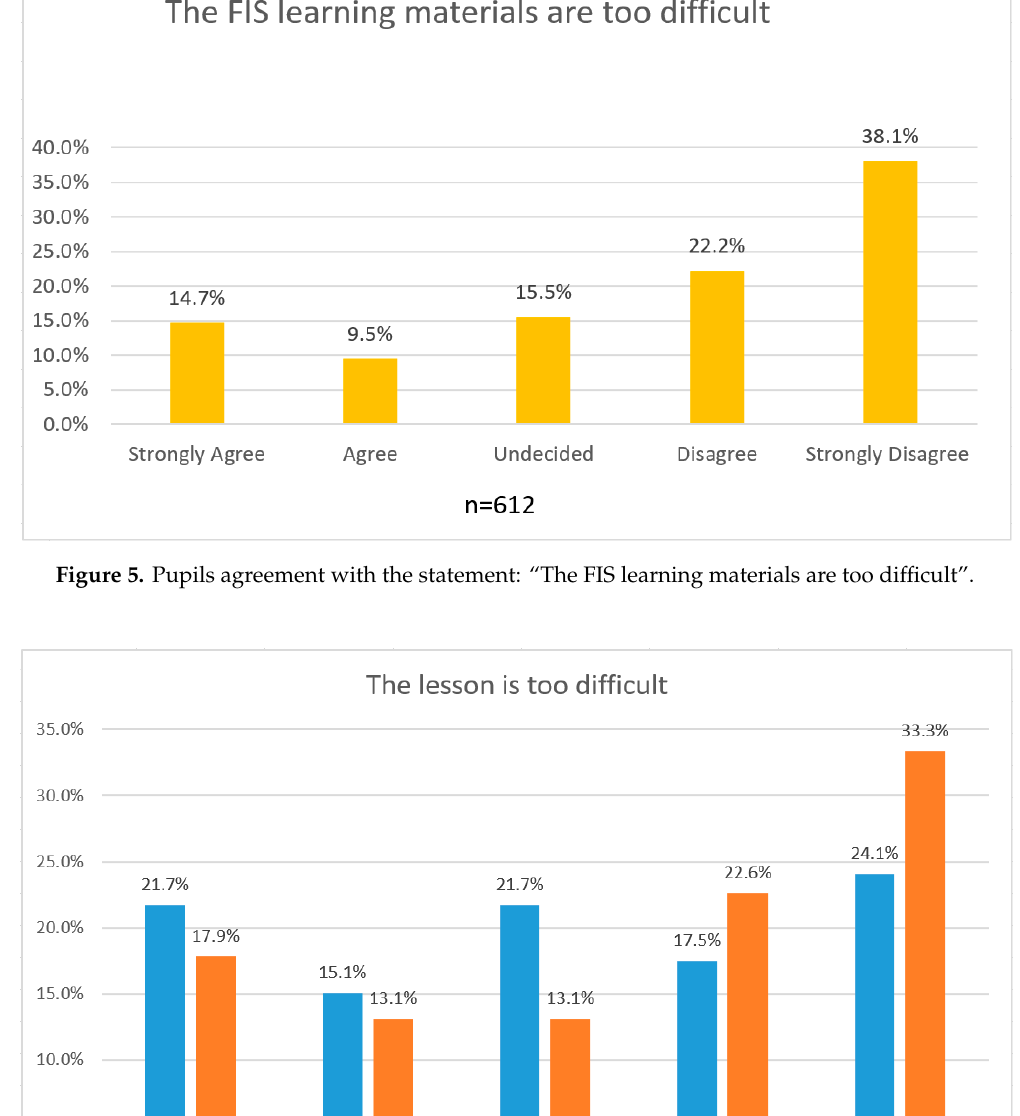
Figure 6. Differences in pupils agreement with the statement: “The lesson is too difficult” in two different classroom